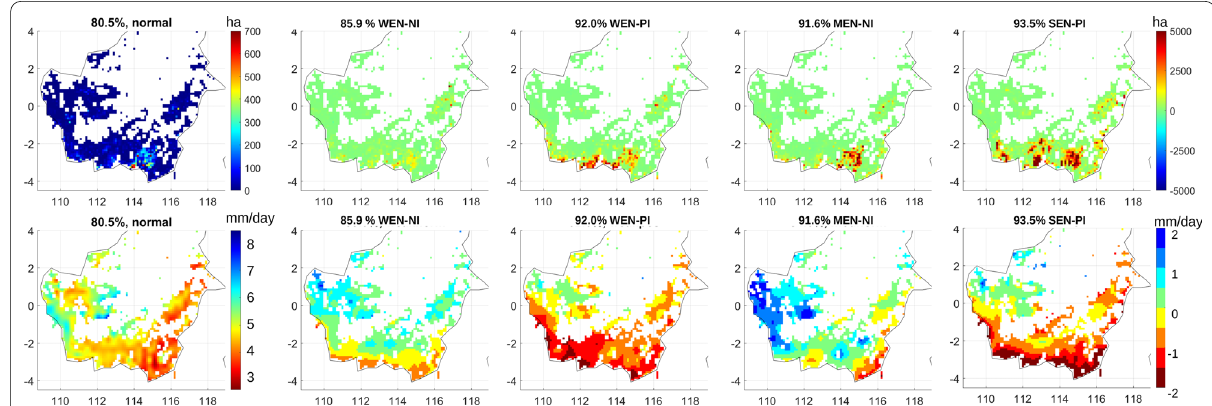
Fig. 6 Spatial of joint Pattern from each category on Kalimantan. In a normal graph, the colour represents an average of total burned area for each grid in the composite year only during fire season (July–November). Other categories represent the difference between each category with value in